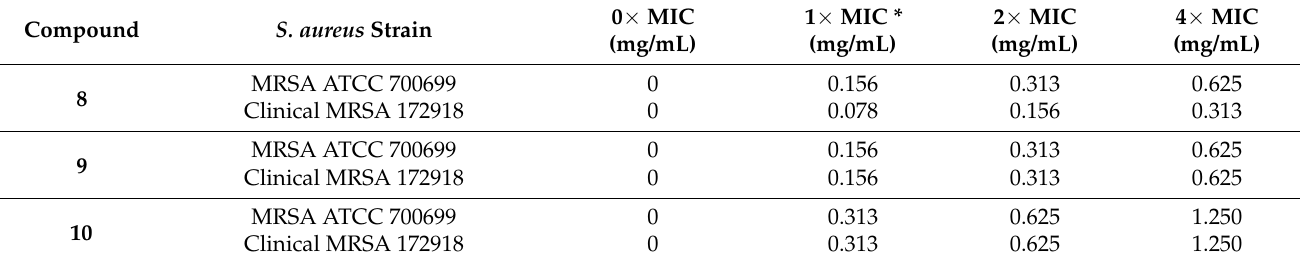
Table 2. Concentrations of compounds 8 , 9 , and 10 used (0 × MIC, 1 × MIC, 2 × MIC and 4 × MIC) for the time-kill test.